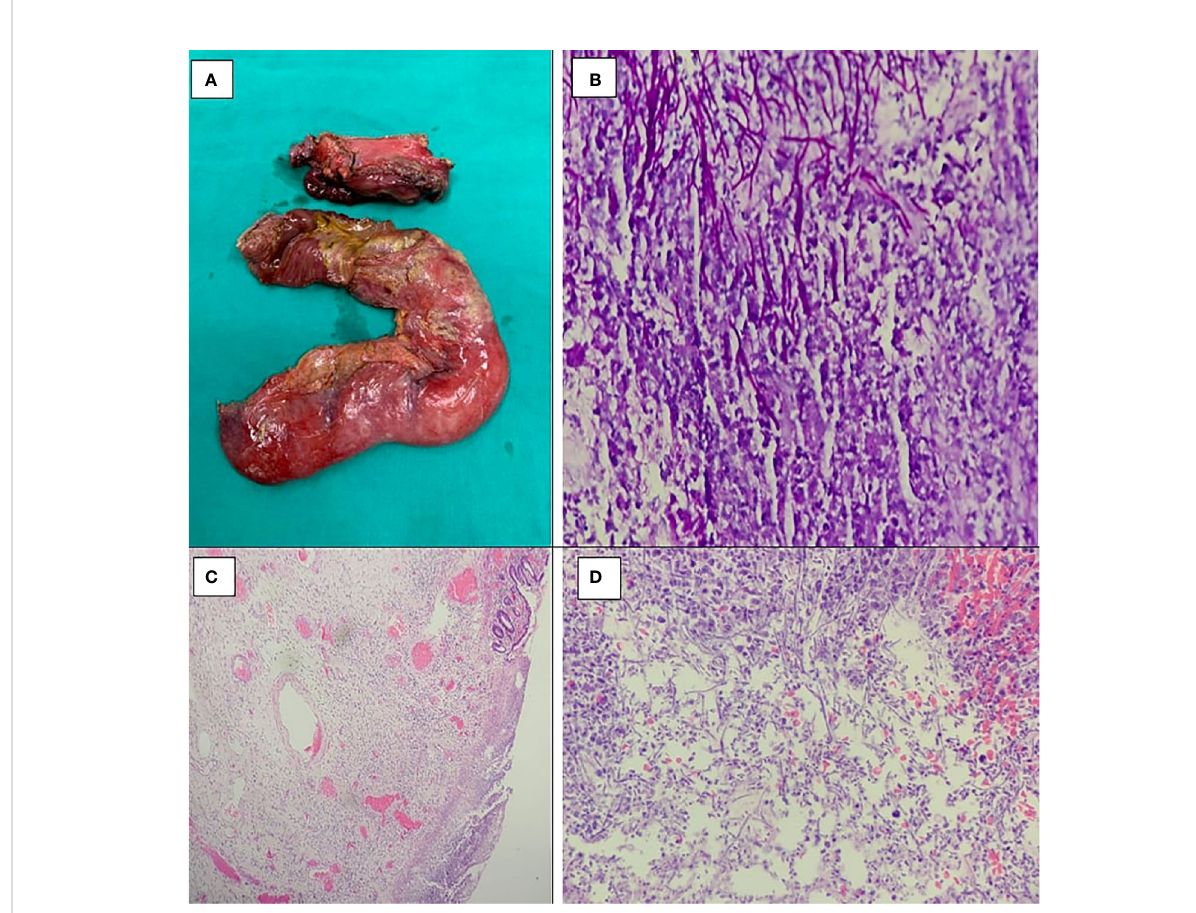
FIGURE 2 (A) The gastrojejunostomosis perforation with peritoneal fl uid. PASx400 (B) , HEx40 (C) , and HEx400 (D) showed Candida spores and budding hyphae invading and destroying adjacent gastric wall and surrounding non-speci fi c in fl